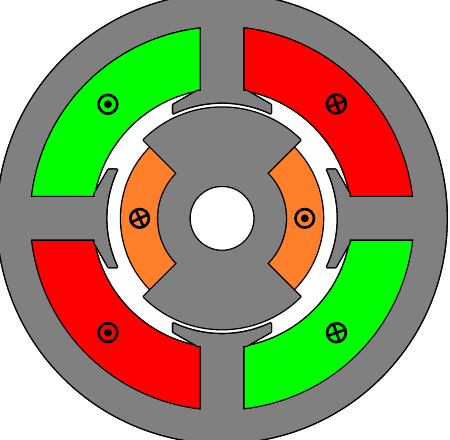
Figure 4. Full pitch winding slotted resolver with four